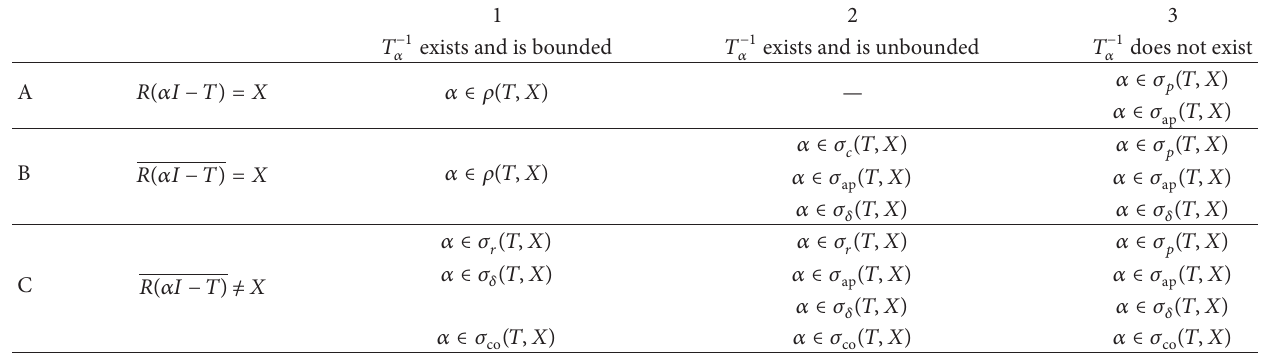
Table 1: Subdivisions of spectrum of a linear